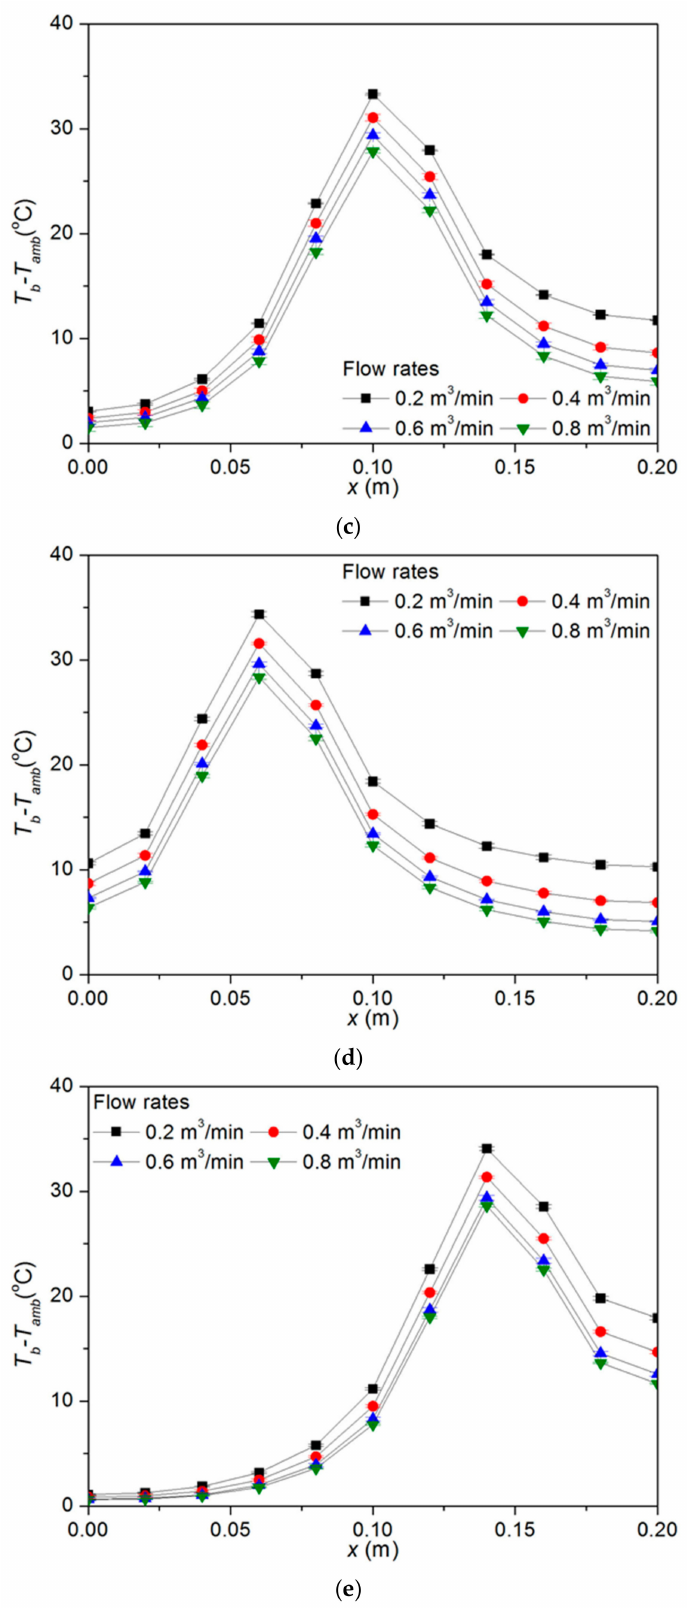
Figure 5. Profiles of di ff erence between base temperature and ambient temperature ( w c = 3 mm). ( a ) L h / L = 1.0, L c / L = 0.5; ( b ) L h / L = 0.6, L c / L = 0.5; ( c ) L h / L = 0.2, L c / L = 0.5; ( d ) L h / L = 0.2, L c / L = 0.3; and ( e ) L h / L = 0.2, L c / L =